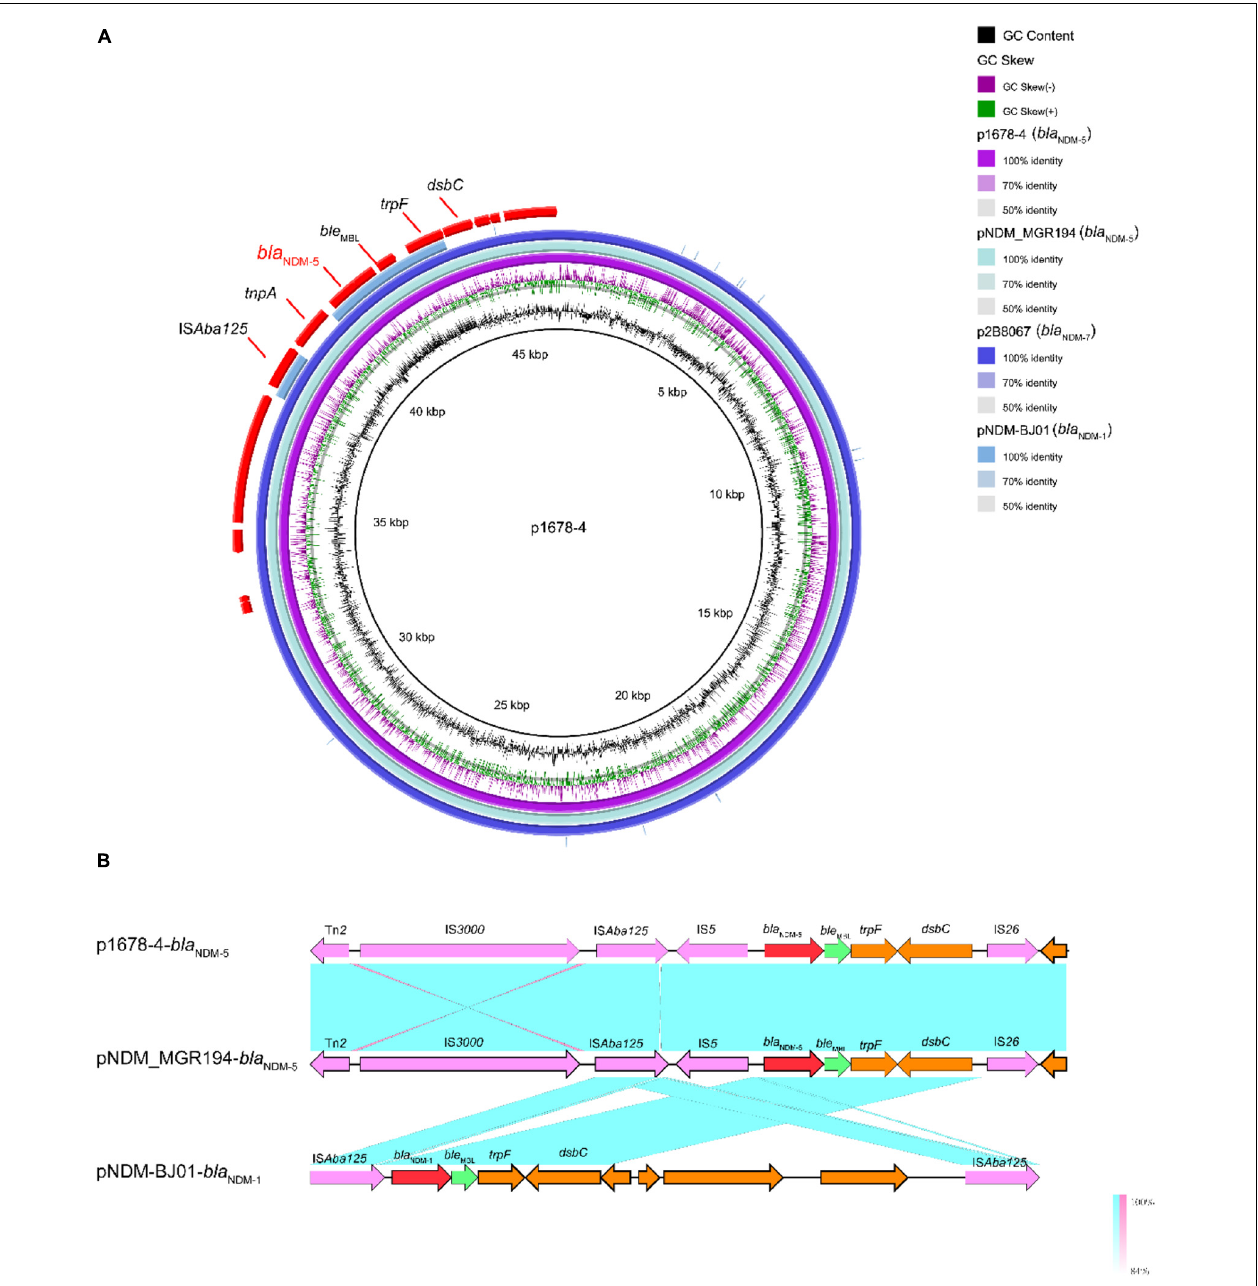
FIGURE 4 | Comparative analysis of pl687-4 plasmids with other reference plasmids. (A) p1678-4 (CP080448) was used as the reference plasmid to perform genome alignment with pNDM-MGR194 ( bla NDM − 5 , KF220657.1), p2B8067 ( bla NDM − 7 , CP070442.1), and pNDM-BJ01 ( bla NDM − 1 , JQ001791). The red arrows represent CDs. (B) Linear comparison of the bla NDM − 5 region. The bla NDM − 5 region was compared with the bla NDM regions extracted from pNDM-MGR194 (